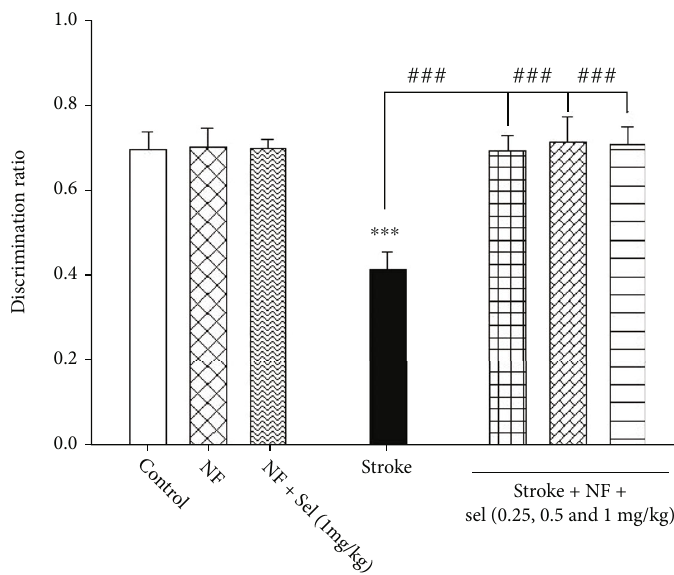
Figure 7: E ff ects of selegiline on behavioral despair in the NOR test. Values are expressed as the mean ± SD and were analyzed using one- way ANOVA followed by Tukey ’ s post hoc test ( n = 7 − 8 ). ∗ P < 0 : 05 , ∗∗ P < 0 : 01 , and ∗∗∗ P < 0 : 001 compared with control group. # P < 0 : 05 and ## P < 0 : 01 and ### P < 0 : 001 compared with transient global ischemia rats. “ NF = nanoformulated containing NBP; NF+sel = nanoformulated containing NBP+selegiline. ”